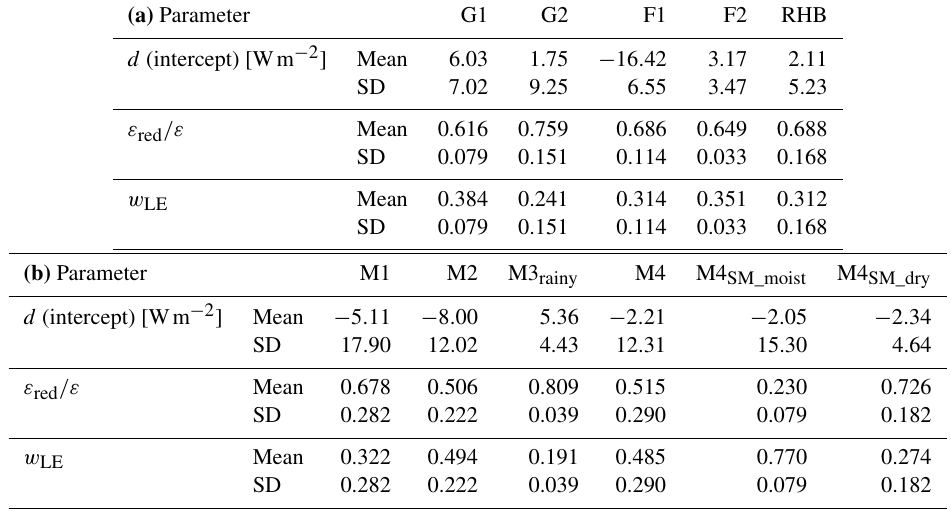
Table 4. (a) Parameters for humid stations. (b) Parameters for Majadas station; semiarid. (a)